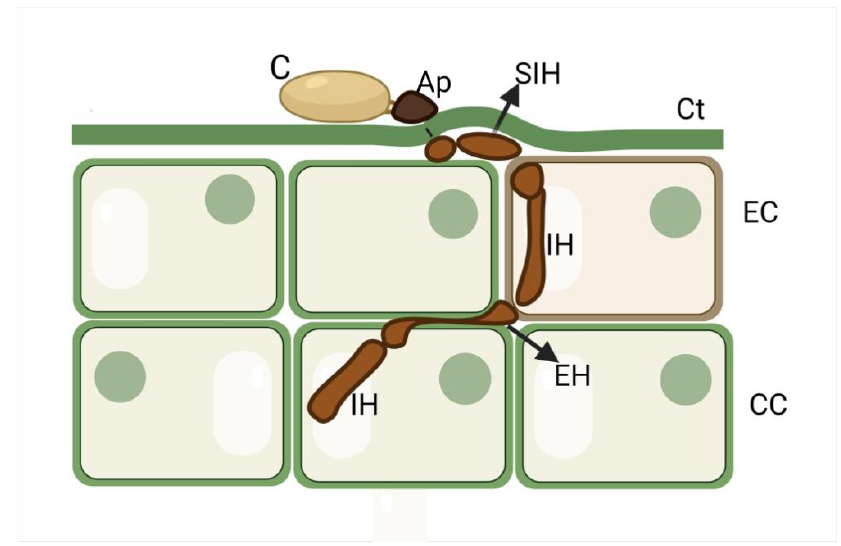
Figure 7. Generalized diagram of the infection strategy used by Colletotrichum lupini in Lupinus mu- tabillis petioles and stems: subcuticular – intracellular hemibiotrophy. Conidium (C) germinates to form melanized appressorium (Ap), from which penetration hypha develop. The host cuticle (Ct) is penetrated and fungal hyphae spread in a subcuticular fashion within the walls of the host epider- mal cells (ECs). This intramural development is associated with the dissolution of the host cell walls, but the adjacent host cells appeared intact (biotrophy). The subsequent steps of the infection in- volved the penetration of epidermal cells and further inter- and intracellular colonization of cortex (CC) and vascular cells. The fungus progressively killed the infected host cells and dissolved the cell walls (necrotrophy). IH = intracellular hypha; EH = extracellular hypha. The diagram is not to scale. Created with Biorender.com.